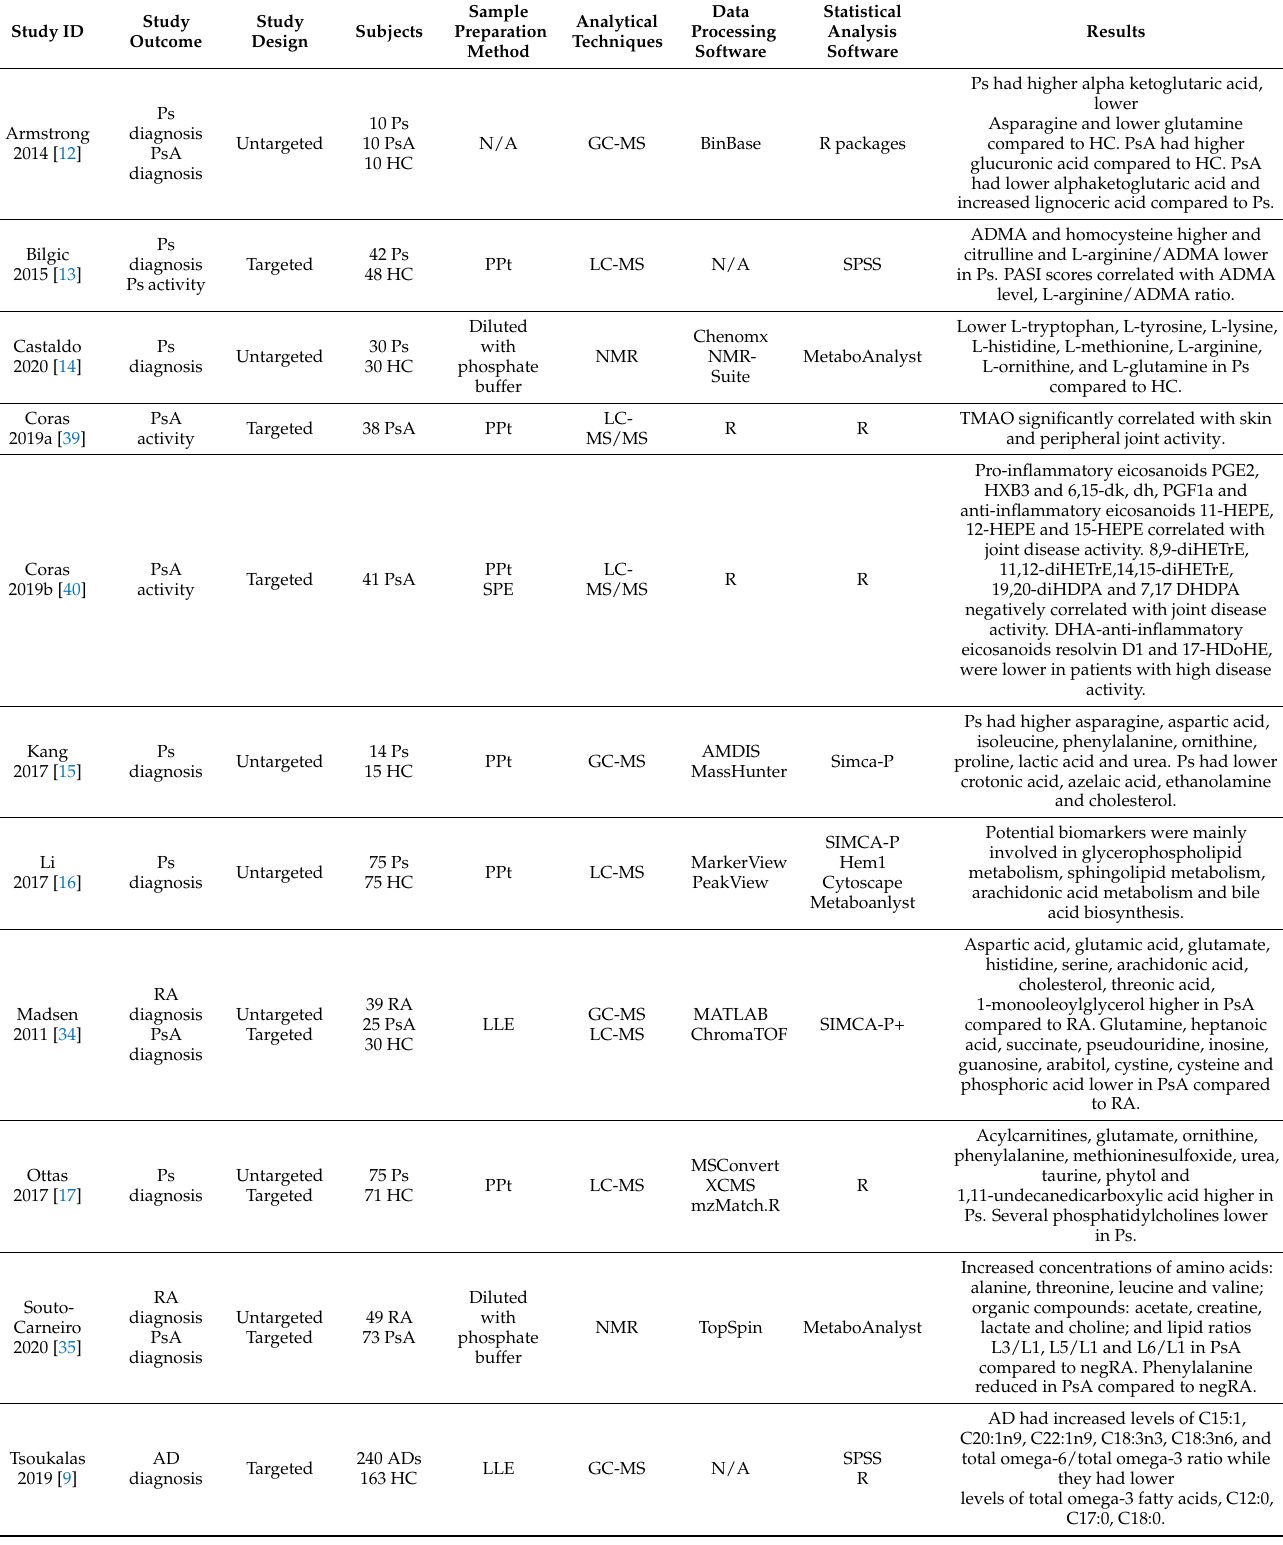
Table 2. Studies in